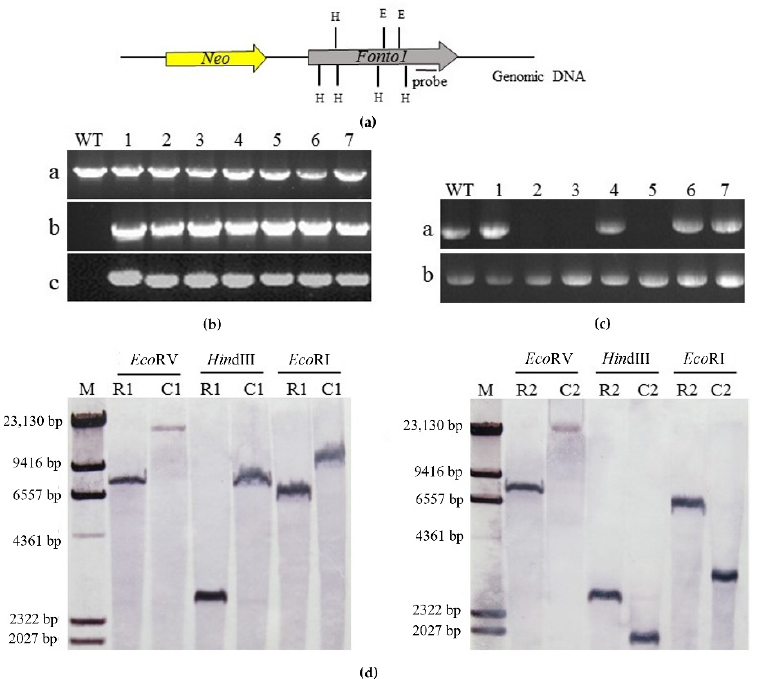
Figure 3. Complementation of the Nto1 deletion mutants. ( a ) Schematic representation of the Nto1 complementation strategy; Nto1 and Neo (selectable marker gene) fragments are denoted by large gray and yellow arrows, respectively. H = Hin dIII digest site; E = Eco RI digest site; ( b ) PCR strategy to screen complemented transformants. WT: wild type; 1–7 = candidate complemented strains. a: PCR performed with primer pair PeF/PeR; a 1.7-kb fragment amplified from Nto1 . b: PCR performed with primer pair HL/HR; a 1.4-kb fragment amplified from Hyg . c: PCR performed with primer pair